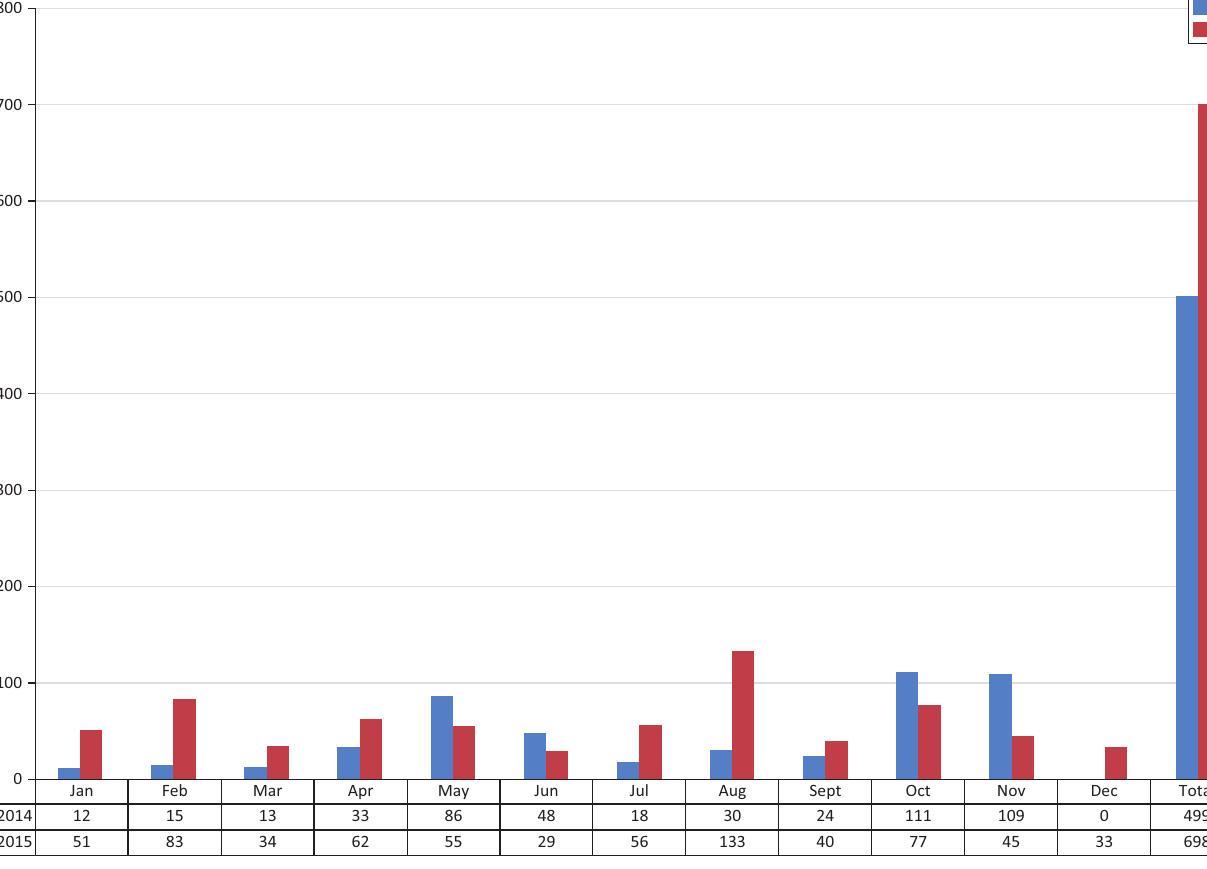
FIGURE 12: Volume of publications uploaded in the open access